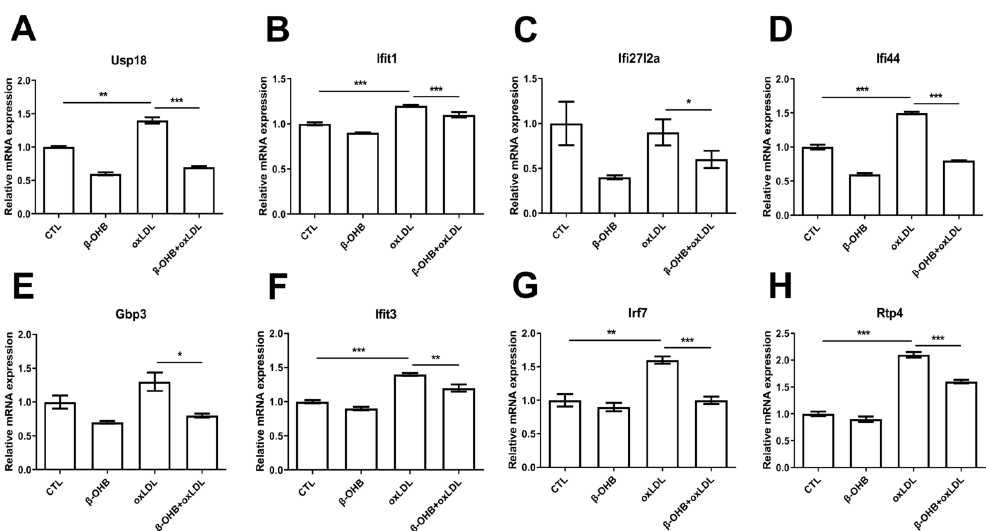
Figure 3. β -OHB decreases ApoE4-specific differentially expressed ChP genes. Quantitative mRNA expressions of ( A ) Ubiquitin specific peptidase 18 (Usp18), ( B ) IFN-induced protein with tetratricopeptide repeats 1 (Ifit1), ( C ) Interferon alpha-inducible protein 27–like 2A (ifi27l2a), ( D ) Interferon-induced protein 44 (ifi44), ( E ) Guanylate-binding protein 3 (gbp3), ( F ) IFN-induced protein with tetratricopeptide repeats 3 (Ifit3), ( G ) IFN-regulatory factor 7 (Irf7), and ( H ) Receptor transporter protein 4 (Rtp4). Data are represented as mean ± S.D. of three independent experiments in duplicates. CTL, control; β -OHB, β -hydroxybutyrate; oxLDL, oxidized low density lipoprotein. * p < 0.05. ** p < 0.001. *** p < 0.0001.